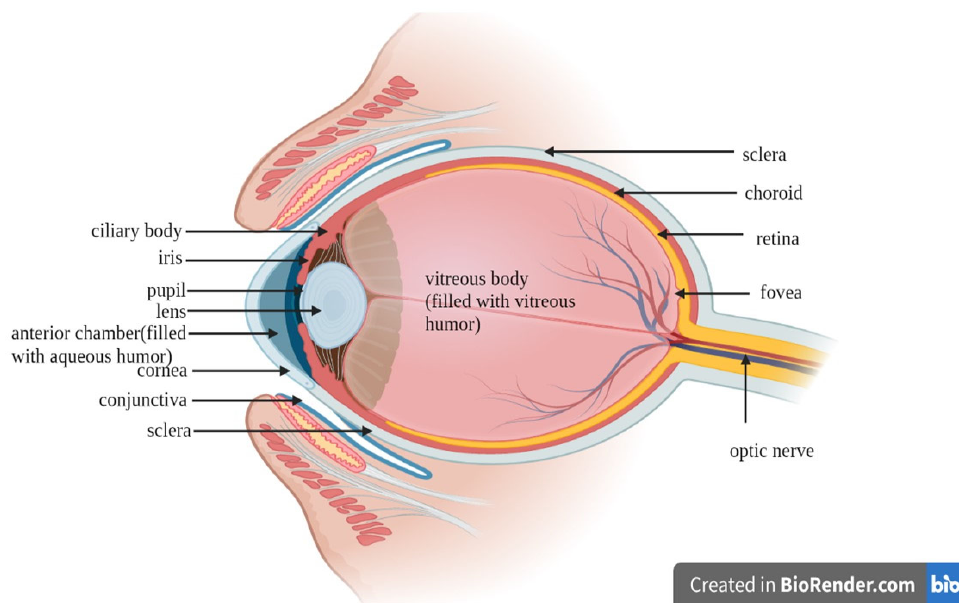
Figure 1. Anatomy of the eye.